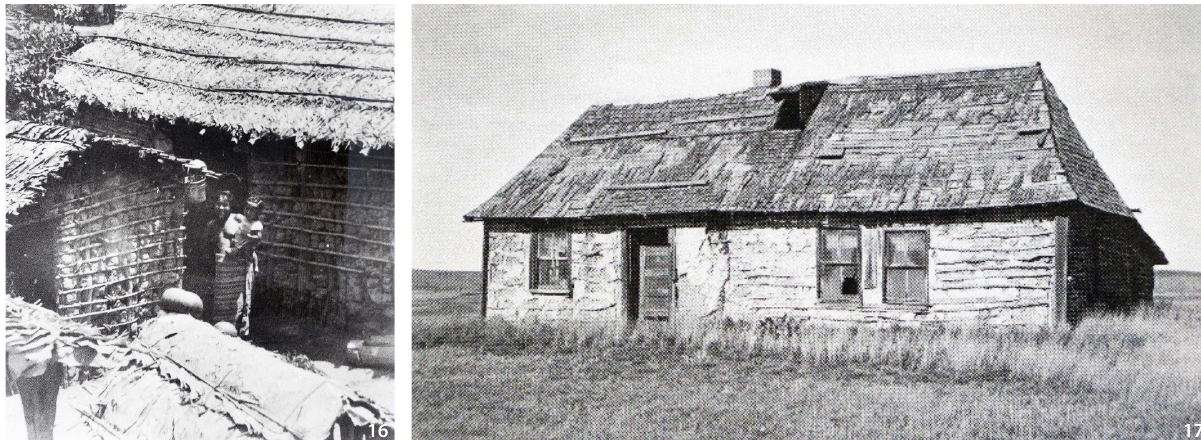
Figure 16 Jamiltepec, Oaxaca, Mexico (Source: Walter Reuter, Prieto 1994, 32). Figure 17 Petro Demaniew house, Dakota, USA, 1908 (Source: Martin 1989,